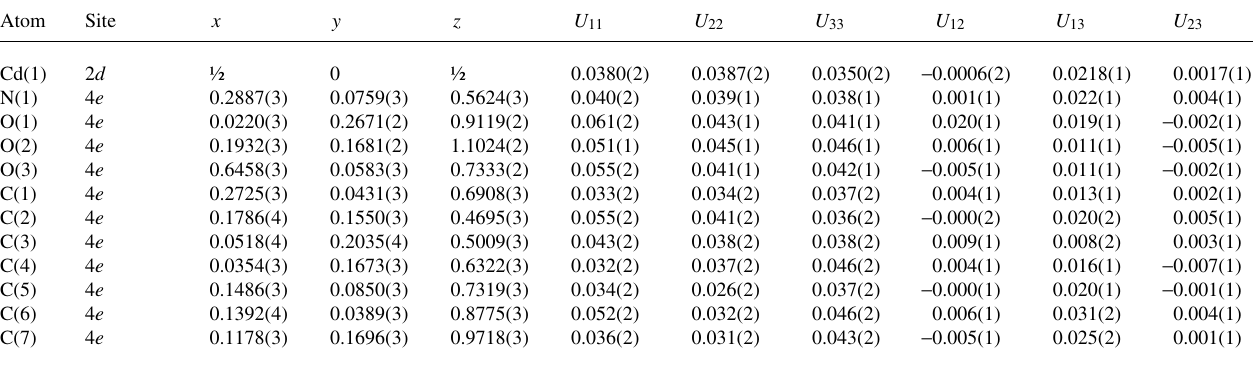
Table 3. Atomic coordinates and displacement parameters (in Å 2 )